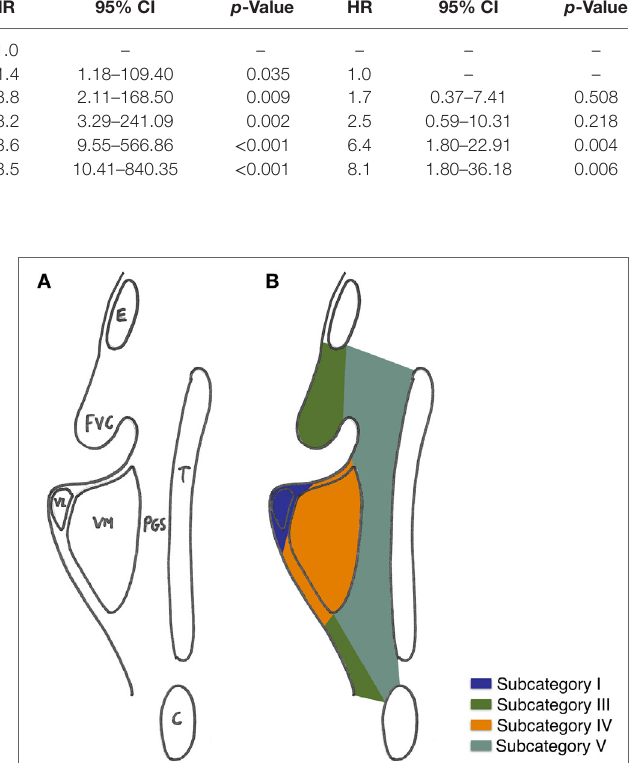
FigUre 6 | (a) Coronal view of the right hemilarynx, anterior half (E, epiglottis; FVC, false vocal cord; VL, vocal ligament; VM, vocal muscle; PGS, anterior paraglottic space; T, thyroid cartilage; C, cricoid) and (b) three-dimensional map of the isoprognostic zones I, III, IV, and V, coronal view of the right hemilarynx, anterior